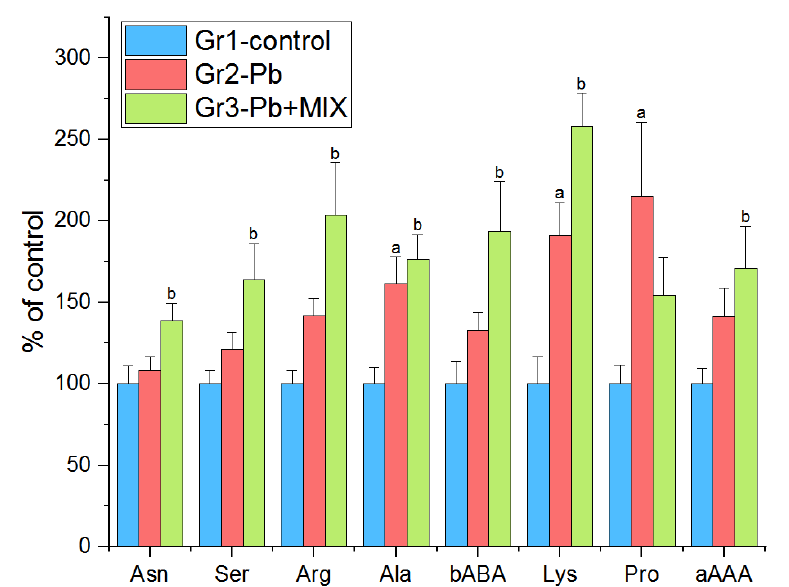
Figure 4. Changes of biomarkers evaluated in plasma ( n = 6; a indicates statistically significant differences between control and Group 2; b indicates statistically significant differences between Group 3 and control group). The results correspond to the mean values (±SE), p < 0.05.